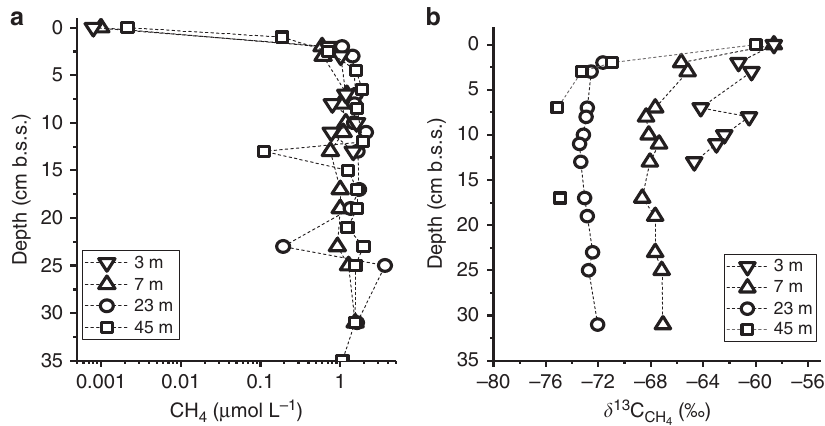
Fig. 5 Porewater CH 4 concentrations and δ 13 C CH4 values. a Pro fi les of porewater CH 4 concentrations (log scale) and b δ 13 C values on sediment cores retrieved at deep sites (S3, 23 m and S4, 45 m) and at shallow stations (S1, 3 m and S2, 7 m) in the proximity of high lake surface CH 4 concentrations: 0.8 µ mol L − 1 ( – 59 ‰ ) at the 3 m site and 1 µ mol L − 1 ( – 59 ‰ ) at the 7 m site. The 3 m site showed extensive gas voids, and some gas bubble release in the retrieved core. All pro fi les were performed on September 2016 except for S4, which refers to